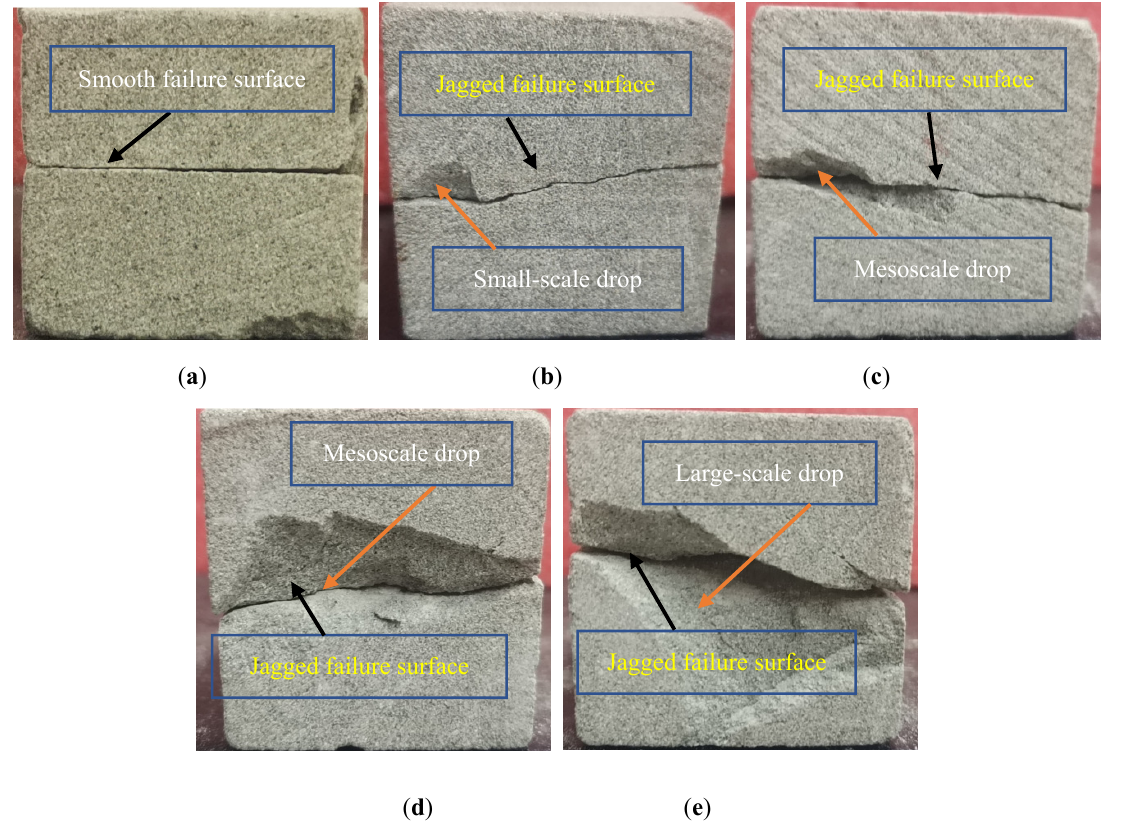
Figure 14. Direct shear experiment results of samples under different axial pressures. ( a ) Sample c1; ( b ) sample c2; ( c ) sample c3; ( d ) sample c4; and ( e ) sample c5.